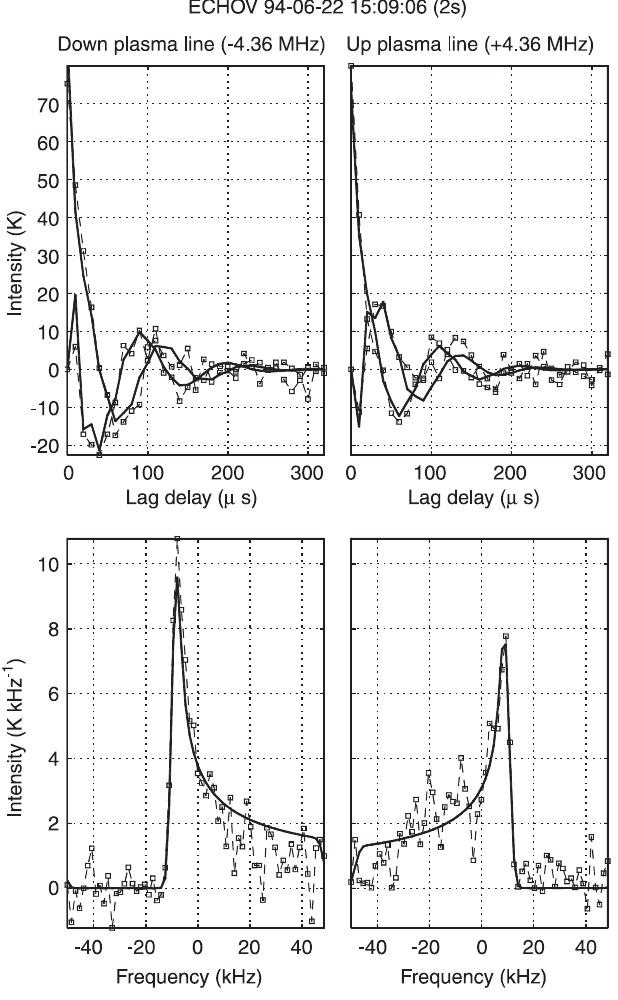
Fig. 2. Example of the result of a fit of the up- and downshifted plasma lines. The two upper panels show the measured complex autocorrelation functions expressed in units of antenna temperature ( dashed line ) and the theoretical model ( solid line ). The curves with the intensity equal to zero at the zero lag delay are the imaginary parts. The two lower panels present the corresponding power density spectrum where the critical frequency is more easily identified in the spectral shape